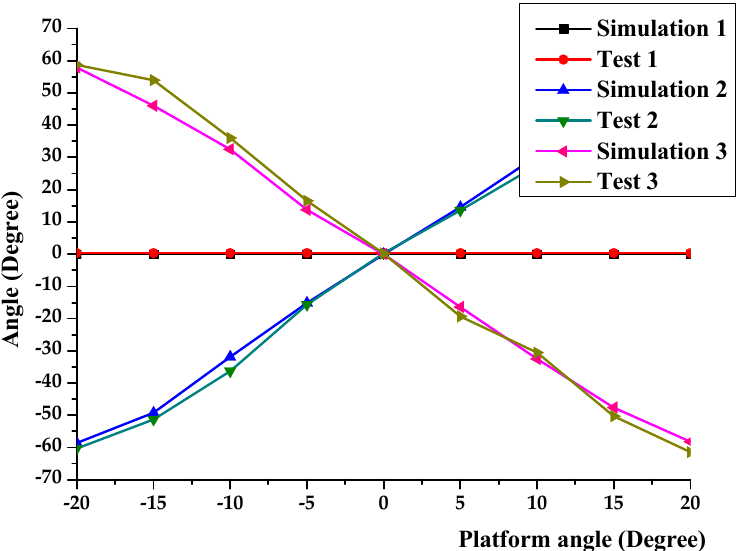
Figure 25. Comparison chart of actual and simulation of roll motion.